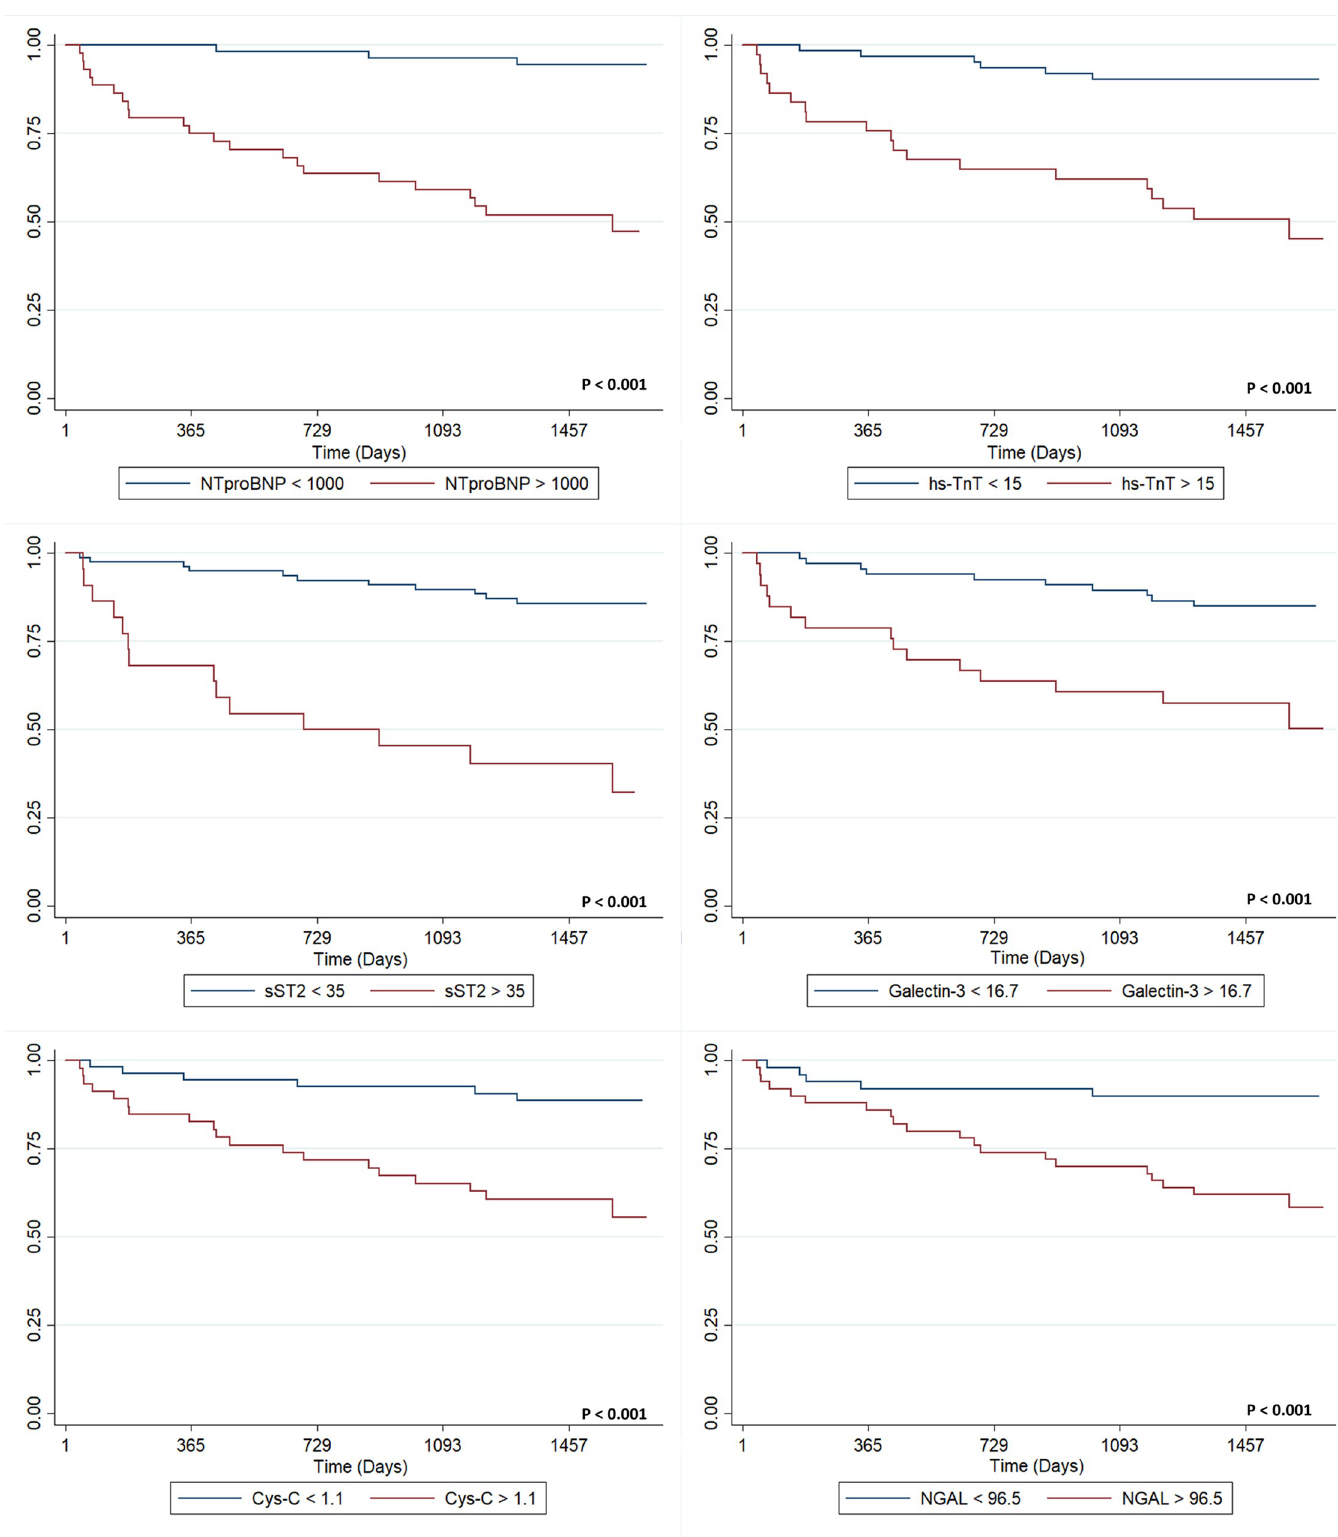
Fig 1. Kaplan Meier survival analyses for the composite outcome stratified by biomarker results above and below selected cut-off values. Survival by results of (A) N-terminal brain natriuretic peptide (NTproBNP); (B) High sensitivity troponin T (Hs-cTnT); (C) sST2; (D) Galectin-3; (E) Cystatin C (Cys-C); (F) Neutrophil Gelatinase-Associated Lipocalin